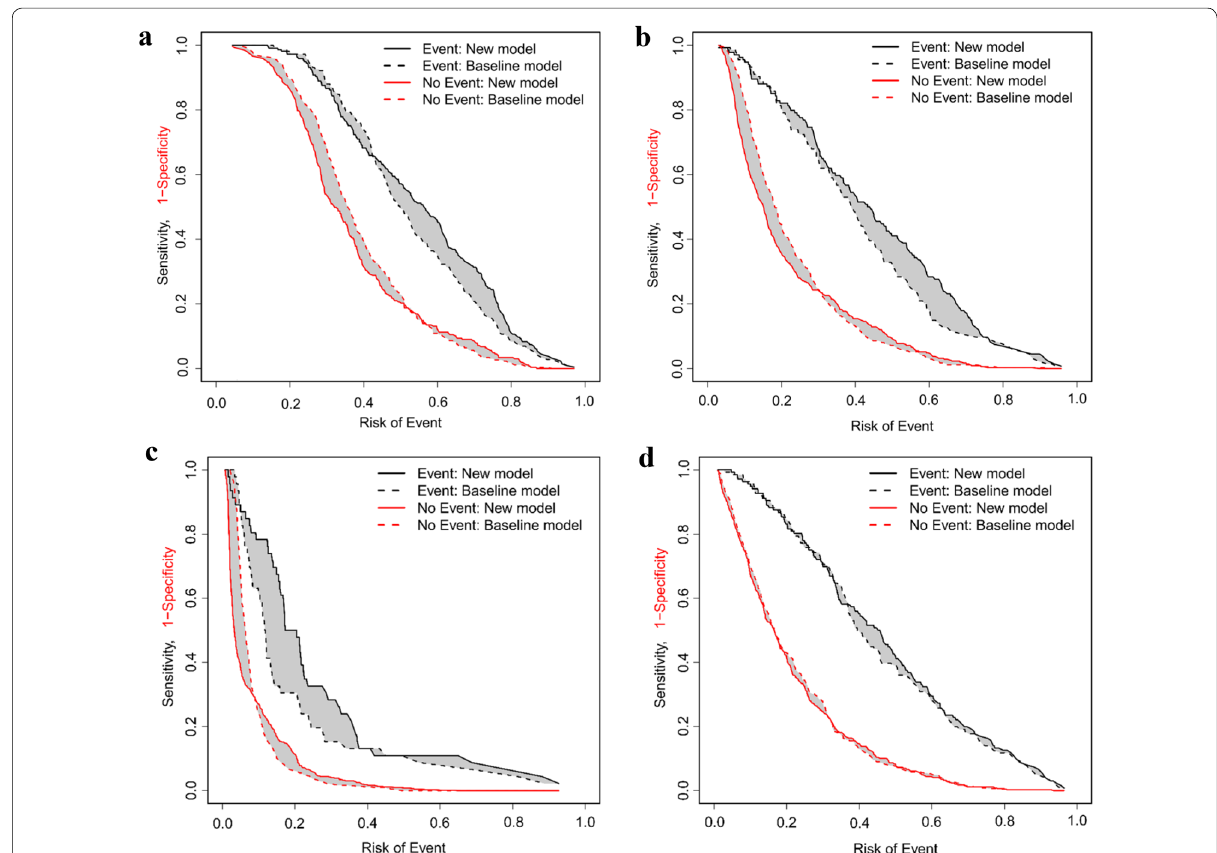
model) represent clinical risk models and solid lines represent new risk models with uNGAL. The gray areas between the solid and the dashed lines represent IDI events (area between black lines) and IDI nonevents (area between red lines). a Visually estimated from the curves, adding uNGAL to the clinical risk model improves separation of patients who will develop AKI when the risk of the event is more than 45%, and discrimination of ≈ patients who will not develop AKI when the risk of the event is less than 50%. b With severe AKI, uNGAL added to the clinical risk model improves ≈ distinguishing KDIGO 2–3 patients when the risk of the event ( severe AKI) is more than 25% and helps separating those with KDIGO stage 0–1 = ≈ when the risk of the event is less than 30%. c Adding uNGAL to the clinical risk model improves the performance for assigning individuals that will ≈ end up with RRT when the risk of the event is lower than 40%, and enhances discrimination of those not ending up with RRT when the risk of the ≈ event is lower than 10%. d Corresponding statistics in Table 2, RAPs for the clinical 90-day mortality risk model and for the new model with uNGAL ≈ added illustrate that uNGAL offers only minimal enhancement separating those who will die by day 90 when the risk of the event is >